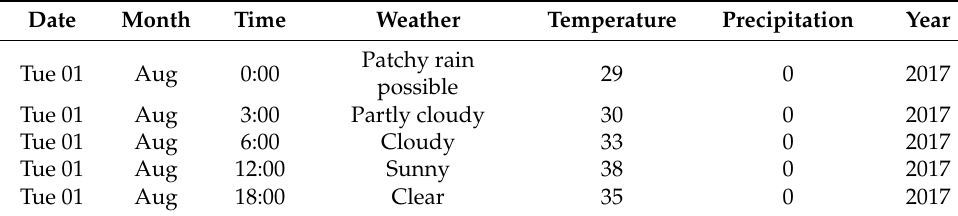
Table 3. Examples of Dataset #2.